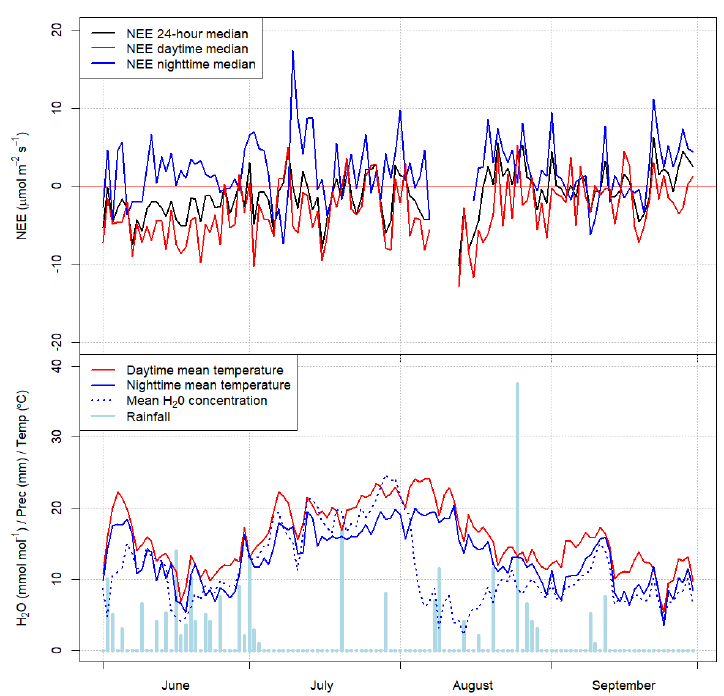
Figure 5. Daily NEE ( µ mol m − 2 s − 1 ) values; nighttime flux ( µ mol m − 2 s − 1 ), daytime flux ( µ mol m − 2 s − 1 ), NEE average ( µ mol m − 2 s − 1 ), temperature (C ◦ ), H 2 O concentration (mmol mol − 1 ), and rainfall (mm) levels over the study period (2014).